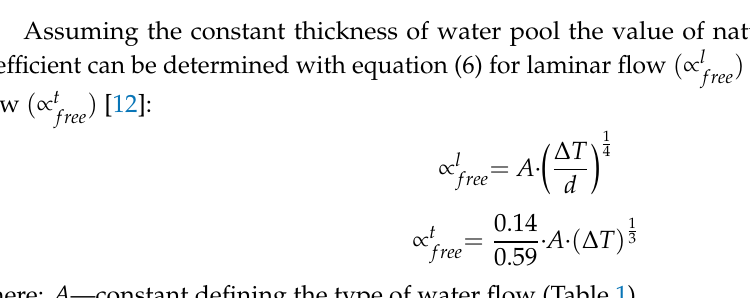
Figure 7. Amount of heat needed to vaporize water having initial temperatures of 5, 15 and 25 ◦ C and to heat up water vapor to 120 ◦ C. Legend: Q1—amount of heat used to heat up water from its initial temperature to 100 ◦ C, Q2—amount of heat used in the vaporization process, Q3—amount of heat used to rise the water steam temperature to 120 ◦ C.